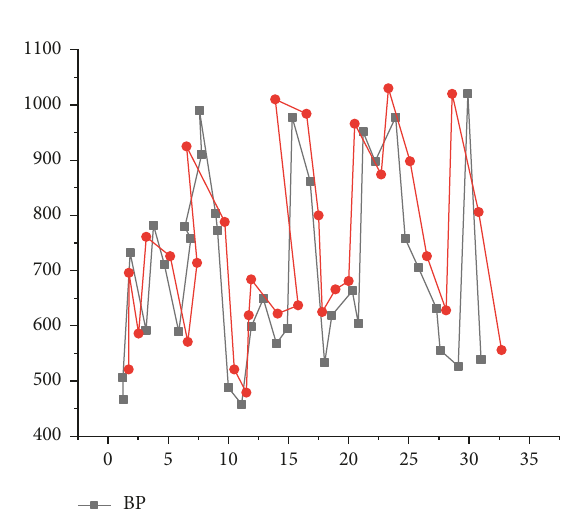
Figure 2: Deformation signal.